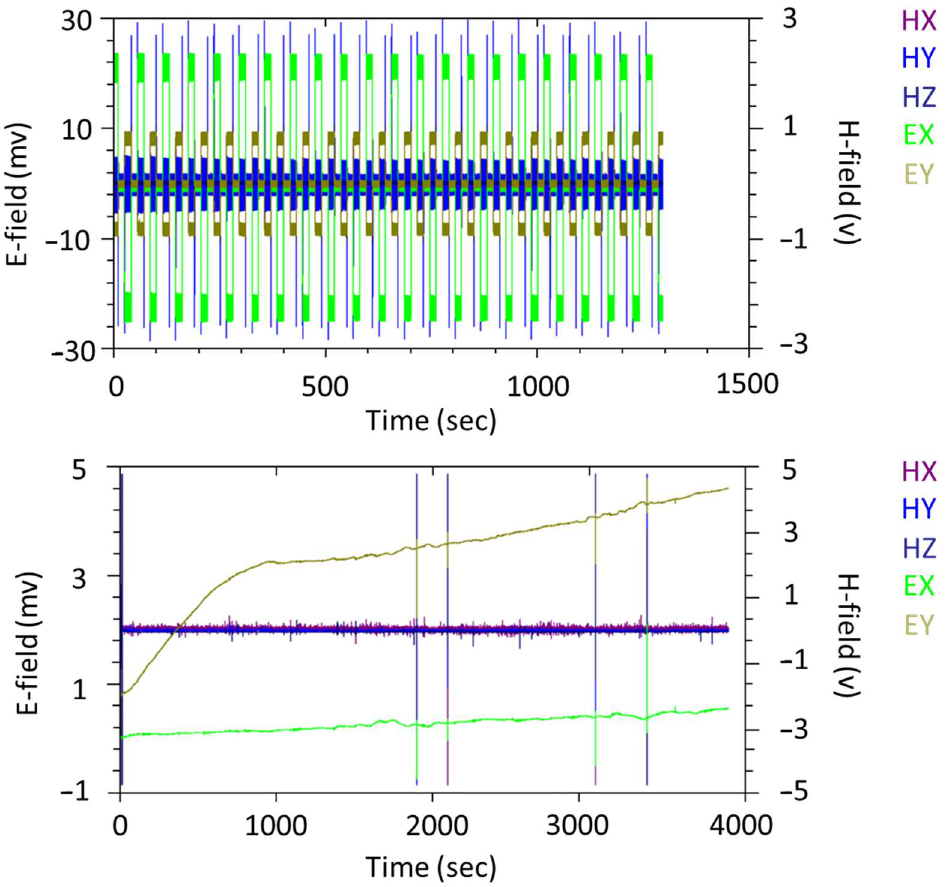
Figure 4. Example of signal display in KMS-820 acquisition program from CSEM with 1 kHz sampling rate ( top ) and MT measurement with 40 Hz sampling rate ( bottom ). The magnetic field (Hx, Hy, and Hz) and electric field (Ex and Ey) are color-coded.